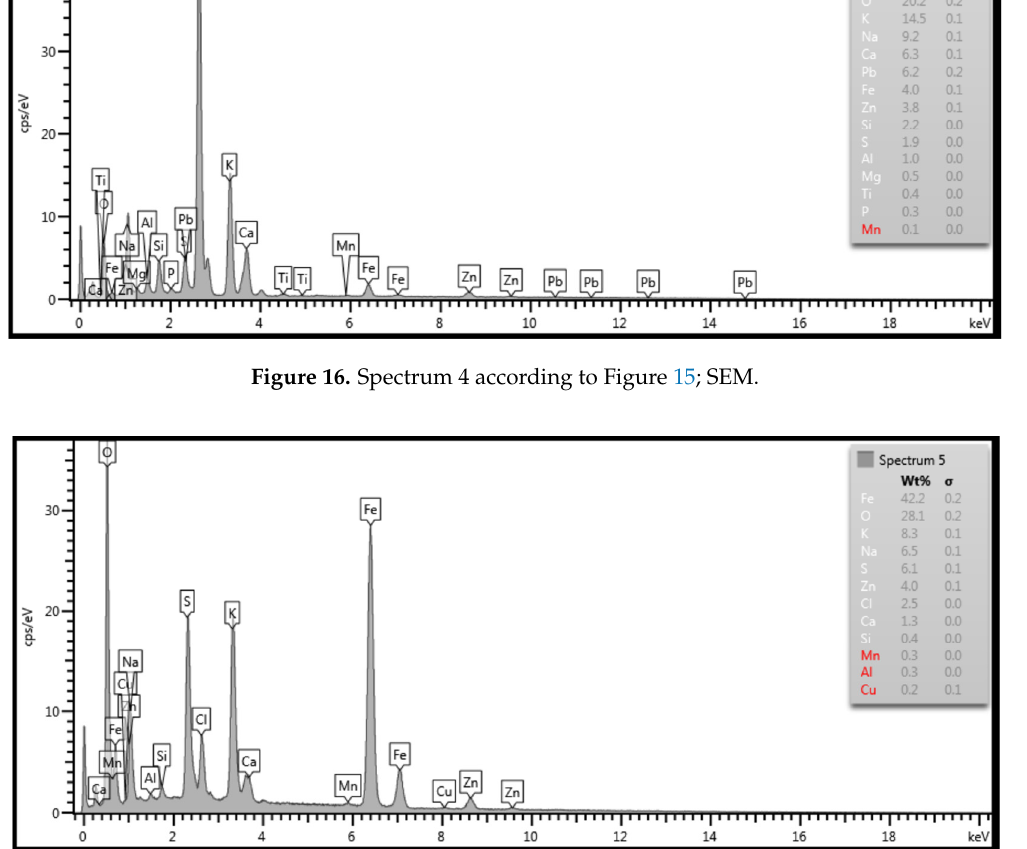
Figure 17. Spectrum 5 according to Figure 15; SEM.